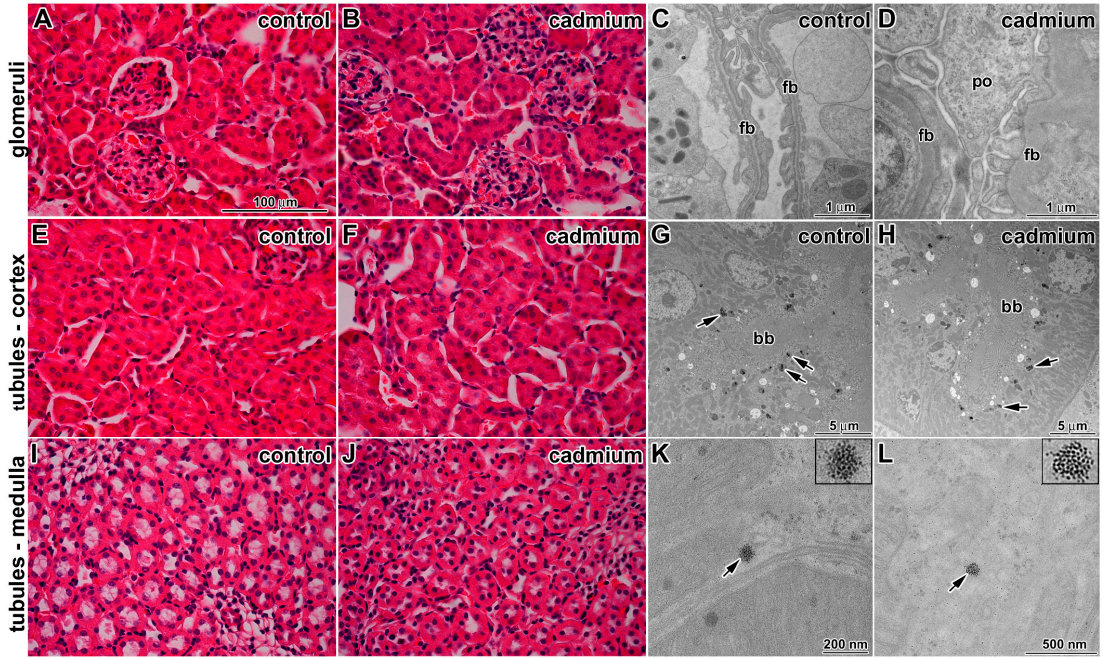
Figure 5. Effect of cadmium nanoparticles on kidney following six weeks exposure to CdO nanoparticles: ( A ) glomerulus in control sample (Hematoxylin-Eosin); ( B ) glomerulus in cadmium treated sample (Hematoxylin-Eosin); ( C ) filtration barrier is thin in control sample; ( D ) alteration of filtration barrier (fb) morphology after treatment, body of podocyte (po); ( E ) unaffected tubules in control tissue (Hematoxylin-Eosin); ( F ) tubules in the kidney cortex of cadmium treated animal (Hematoxylin-Eosin); ( G ) proximal tubule in control sample, (bb) signs of brush border, arrows show secondary lysosomes with dense granular content; ( H ) proximal tubule after cadmium treatment, (bb) signs of brush border, arrows show secondary lysosomes with dense granular content without nanoparticles; ( I ) unaffected tubules in control tissue of medulla (Hematoxylin-Eosin); ( J ) tubules in the kidney medulla of cadmium treated animal (Hematoxylin-Eosin); and ( K , L ) cadmium nanoparticles (arrows) freely in epithelial cell cytoplasm of proximal tubules. Scale bar A,B,E,F,I,J = 100 µm.